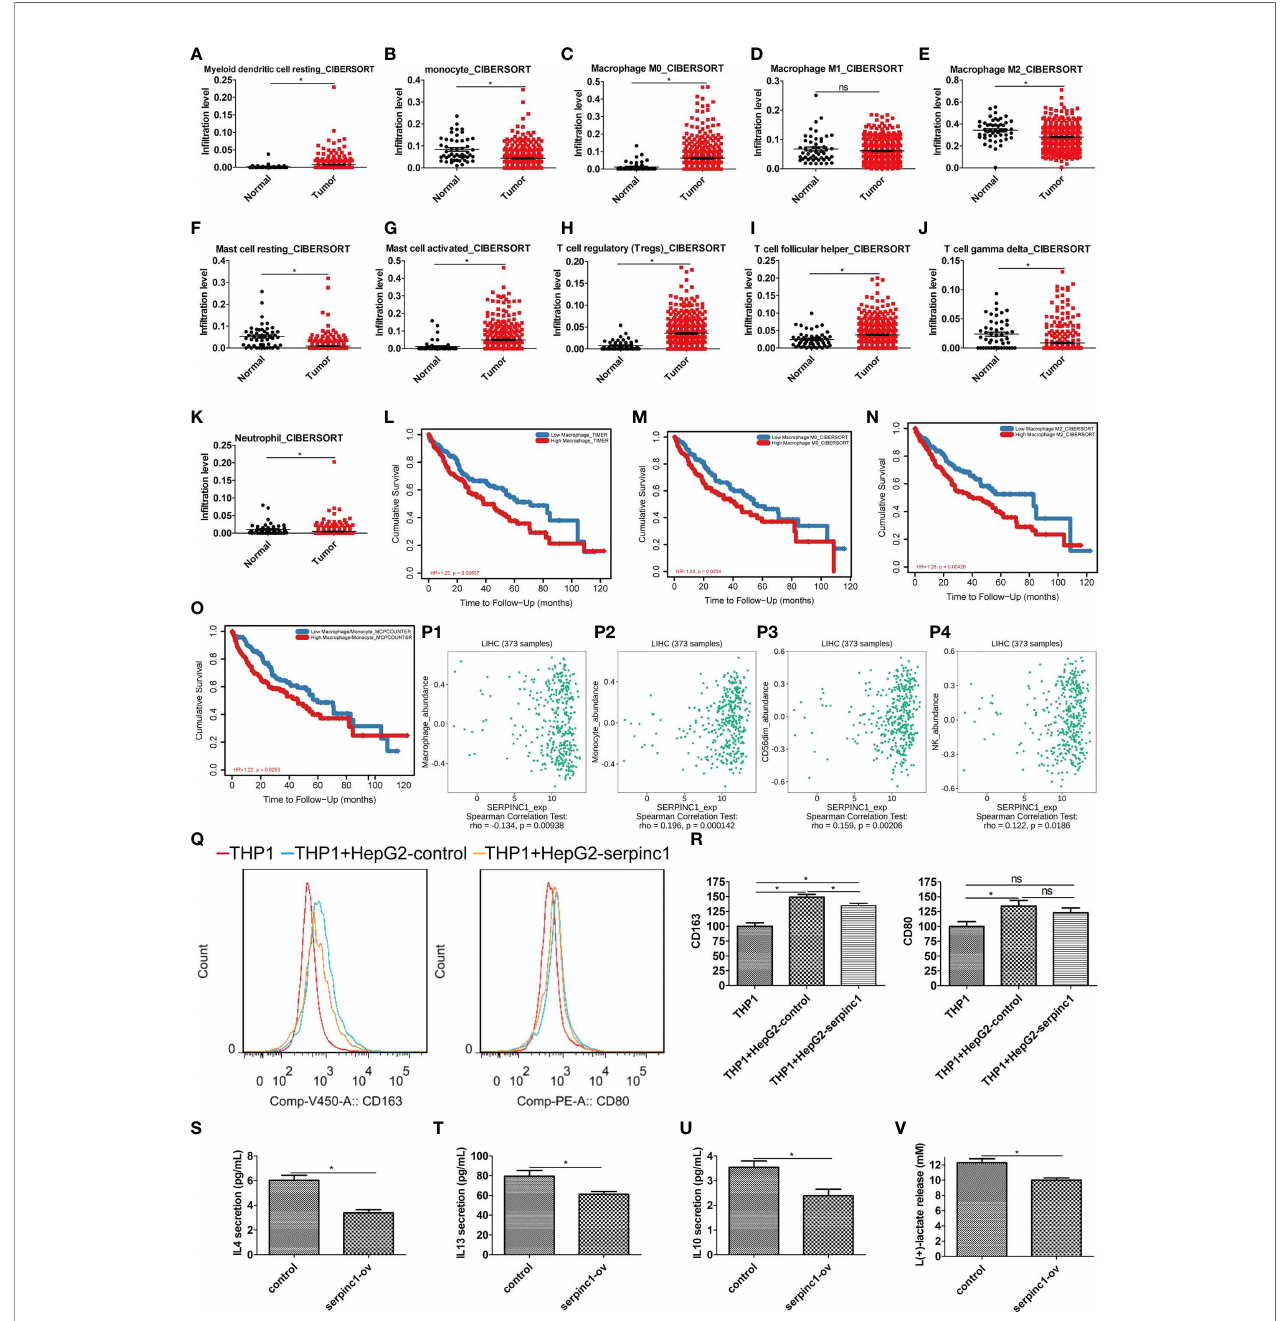
FIGURE 4 | Serpinc1 expression inhibited macrophage M2 immune in fi ltration in hepatocellular carcinoma. (A – K) Analysis of immune cell in fi ltration abundance in hepatocellular carcinoma and normal controls with CIBERSORT. Myeloid dendritic cell resting (A) , Monocyte (B) , Macrophage M0 (C) , Macrophage M1 (D) , Macrophage M2 (E) , Mast cell resting (F) , Mast cell activated (G) , T cell regulatory (H) , T cell follicular helper (I) , T cell gamma delta (J) , and Neutrophil (K) . (L – O) Analysis of correlation between lymphocyte and outcomes in hepatocellular carcinoma patients from TIMER2.0 database. Macrophage (L) , macrophage 0 (M) , macrophage 2 (N) , and macrophage/monocyte (O) . (P1 – P4) Analysis of correlation between serpinc1 and immune in fi ltration from TISIDB database. Macrophage (P1) , monocyte (P2) , NK CD56dim (P3) , and NK (P4) . (Q, R) THP1 cells activated by 50 nM PMA were co-cultured with HepG2 overexpressed control (blue) or serpinc1 (yellow) or alone (red). Macrophage M2 marker CD163 and M1 marker CD80 were detected by fl ow cytometry. Representative image (Q) and statistical analysis (R) . (S – V) HepG2 cells were overexpressed control or serpinc1, and analyzed the macrophage M2-associated factors in culture medium. Statistical analysis of IL4 (S) , IL13 (T) , IL 10 (U) , and lactate (V) . * P < 0.05, ns, no signi fi cant, P >